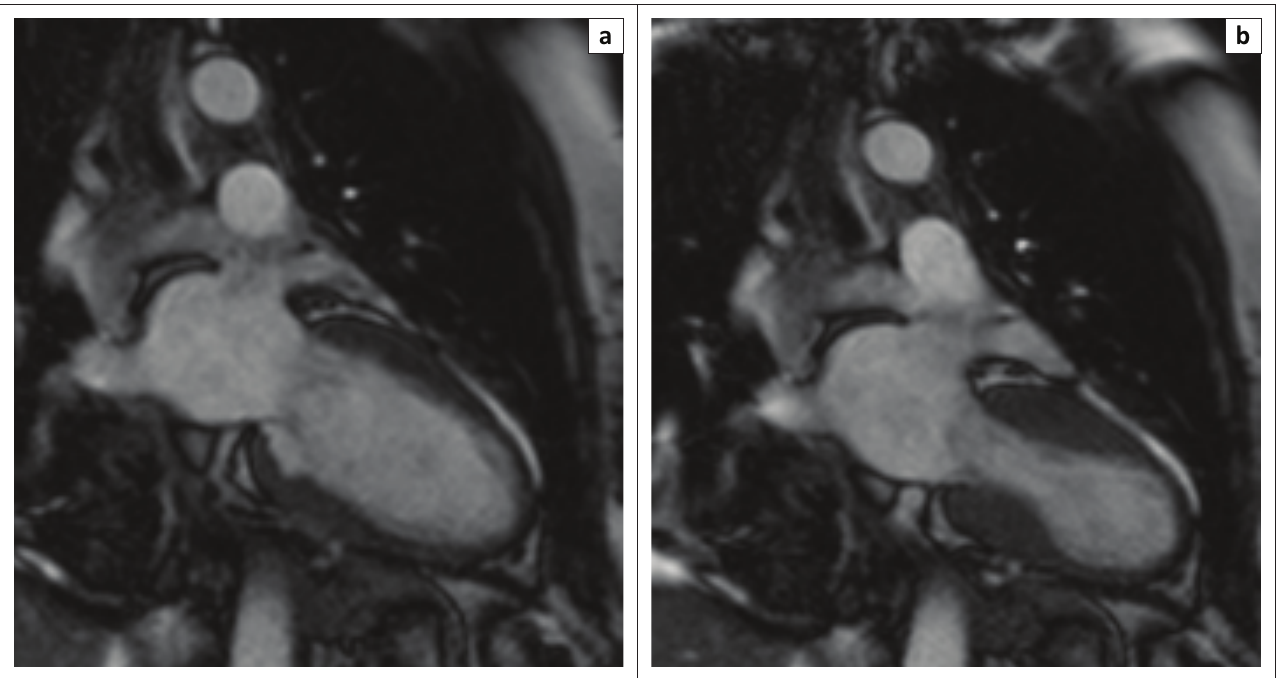
FIGURE 10: Takotsubo. Two-chamber cine b-SSFP at end-diastole (left) and end-systole (right) demonstrating a hypokinetic apex and mid LV, resulting in a Japanese ‘octopus trap’ appearance on the end-systole